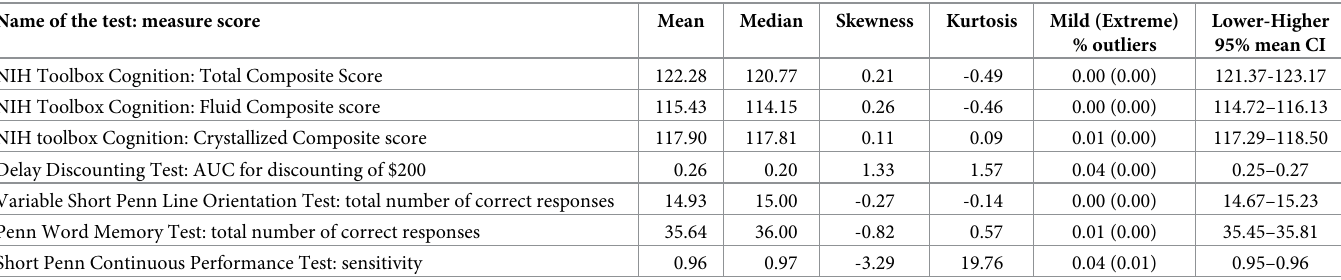
Table 1. Main descriptive statistics for the response cognitive